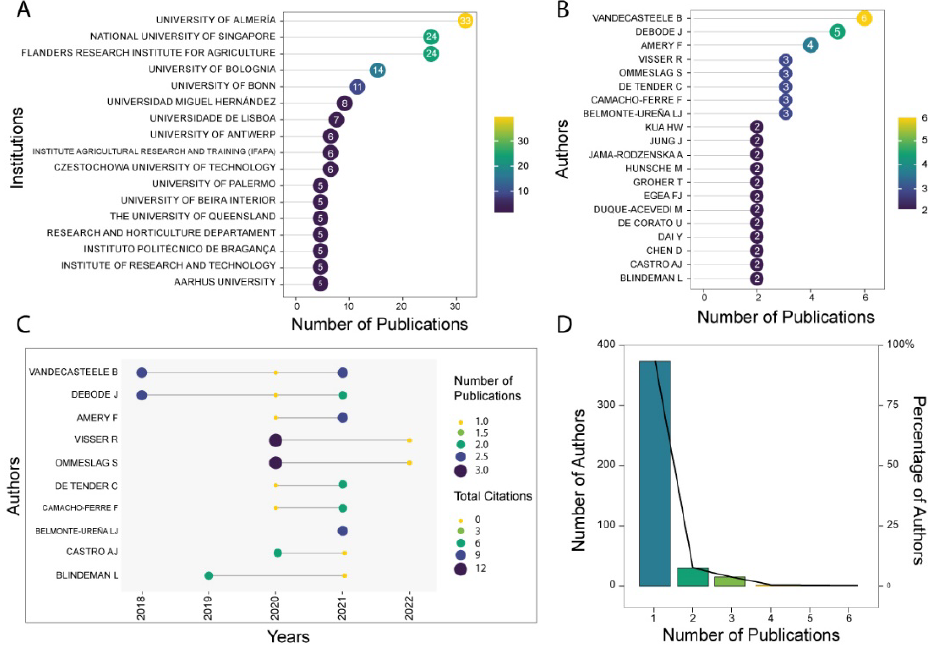
Figure 5. Publications productivity of institutions and authors on circular horticulture. Top 10 institutions with the highest number of publications ( A ), Top 10 authors with the highest number of publications ( B ), production over time of the authors ( C ), and use of the Lotka’s Law ( D )—own elaboration.